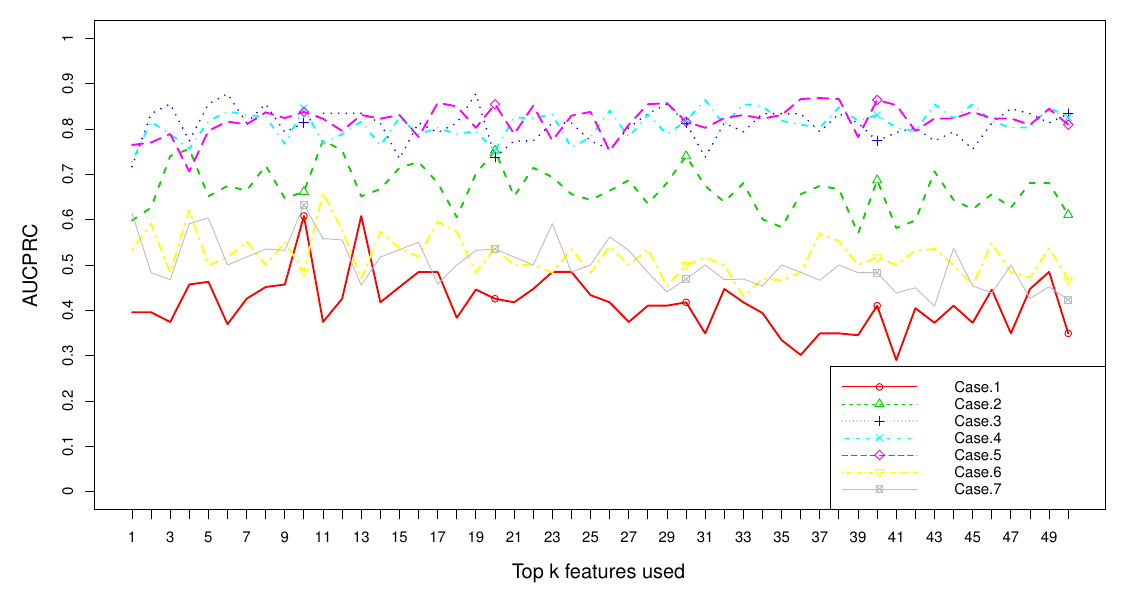
Figure 8. AUCPRC when top k features are used with the dataset “CHD2-1” on seven